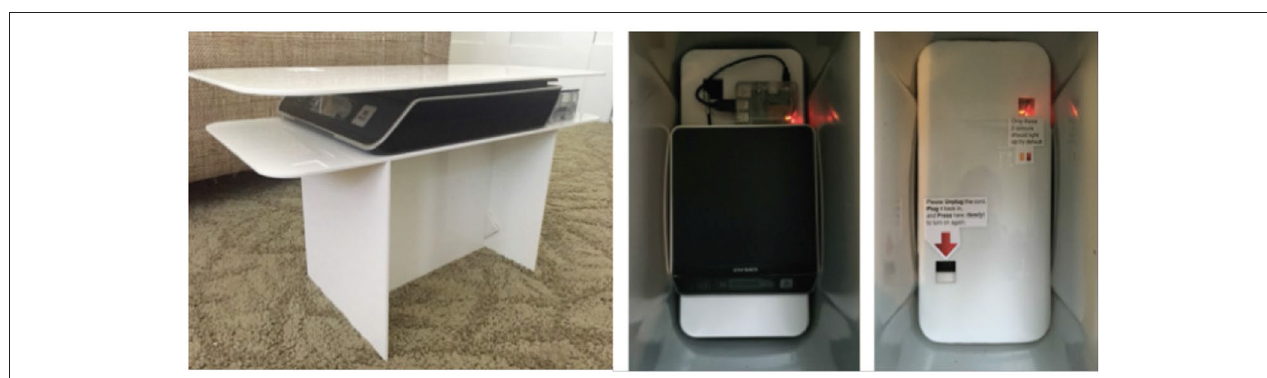
Frontiers in Sustainable Food Systems |